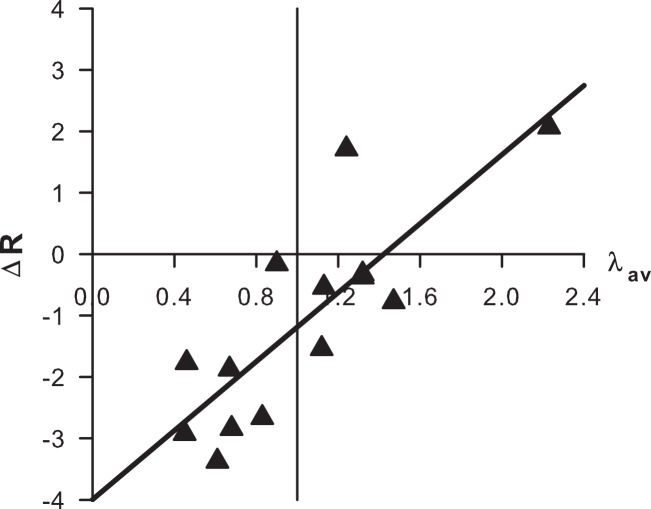
Regression of ΔR (standardized residuals from expected number of recaptures, from Eq. (5)) on male fitness (average number of matings, λav).The vertical line marks a fitness of 1.0. Regression equation: ΔR = 2.81λav−3.99, p = 0.0004, R2 = 0.67. (Note that the two data points from early-season 2007 and early-season 2010 overlap (see Table 3); there are actually 14 data points contributing to the regression.)